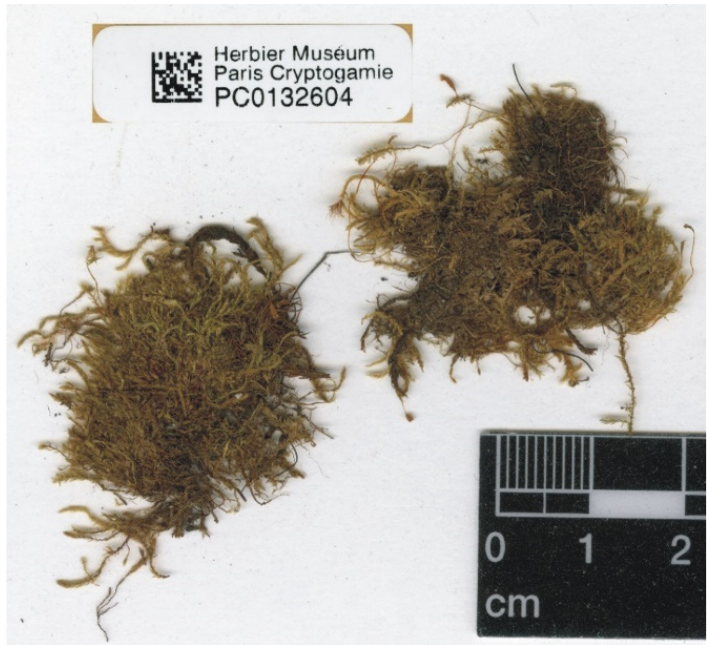
Figure 8. Turfs of P . sandbergii , specimen PC0132604. From the herbarium PC website (https://sci- ence.mnhn.fr), downloaded 15 April 2022.